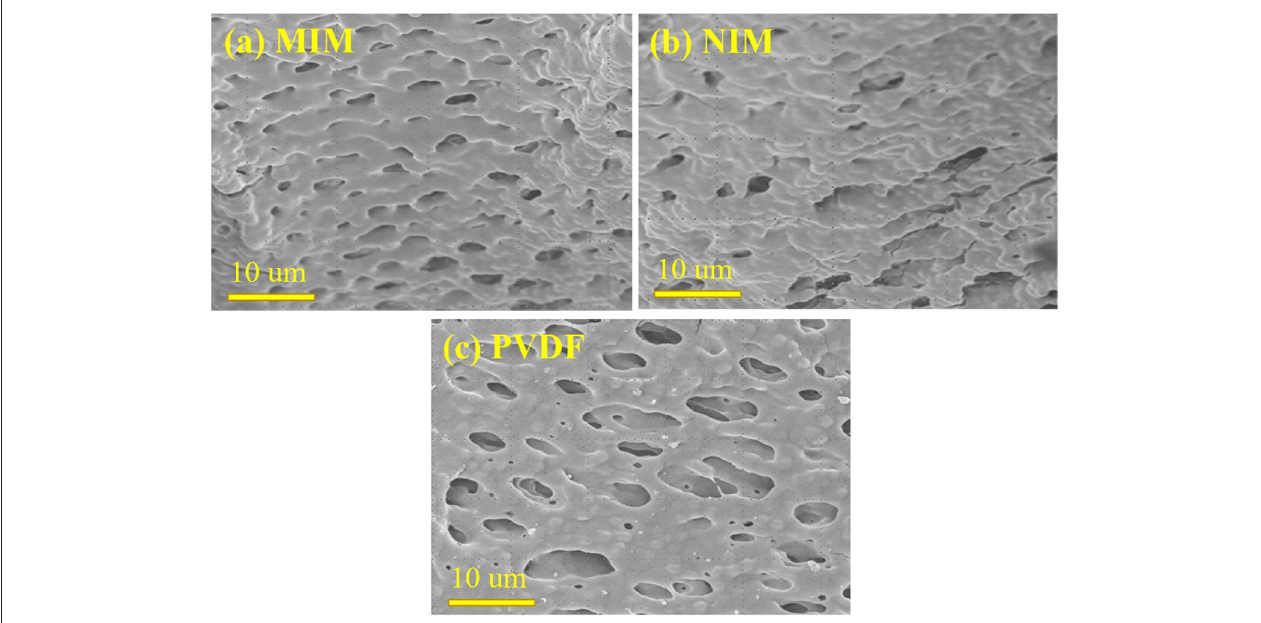
FIGURE 2 | SEM of (A) MIM7, (B) NIM7, and (C) PVDF.